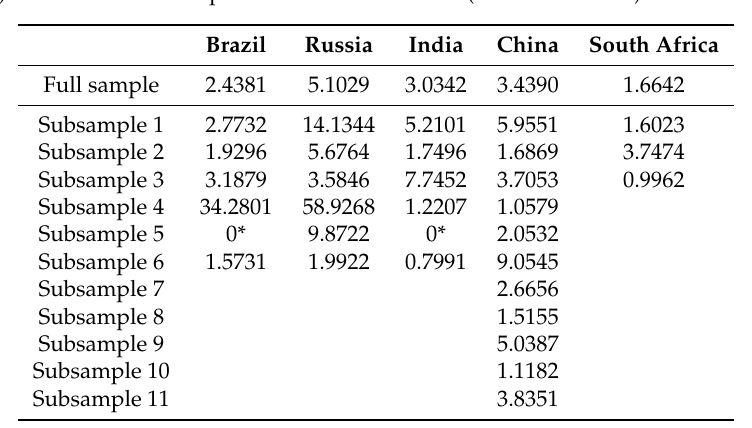
Table 3. Unconditional variance for the GARCH(1,1) full sample model and for the sub-sample defined by the identified structural breaks. The values 0* are obtained in correspondence of an estimated GARCH(1,1) model in which the persistence in near to one (IGARCH model) and ω is equal to